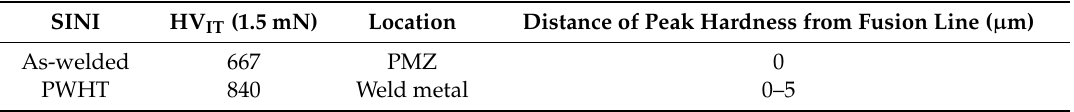
Table 3. Summary of the main hardness results and their locations at the LAS / Alloy 52 weld metal for SINI AW and SINI PWHT.